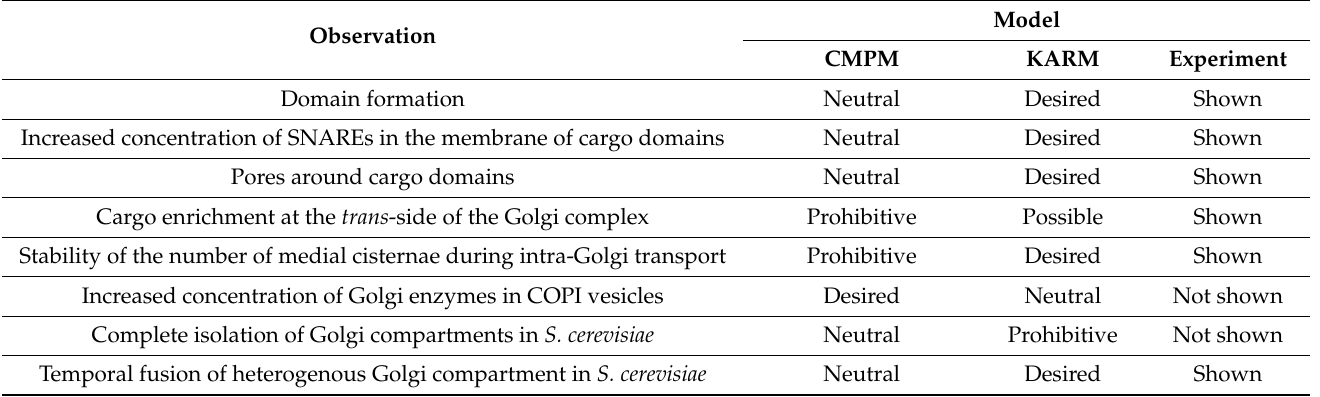
Model CMPM KARM Experiment